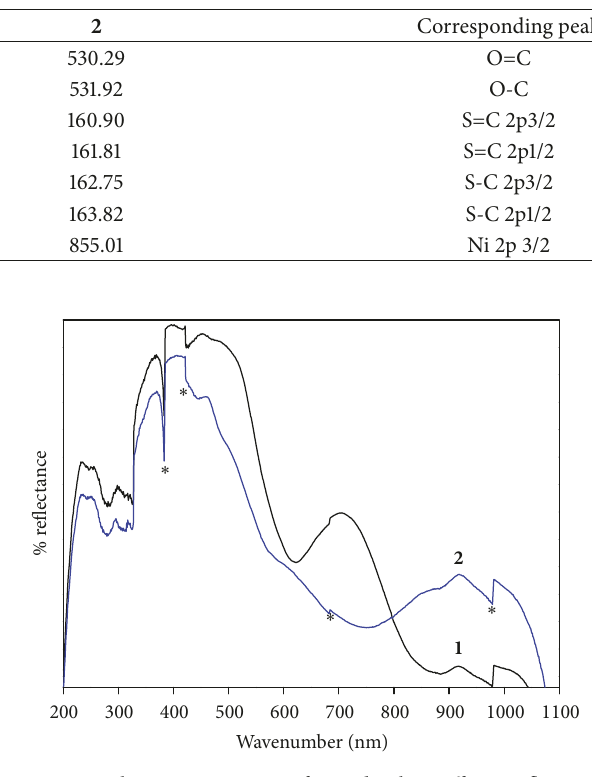
Figure 3: Absorption spectra of 1 and 2 by Diffuse Reflectance spectroscopy; ∗ systematic signals associated with the nature of the